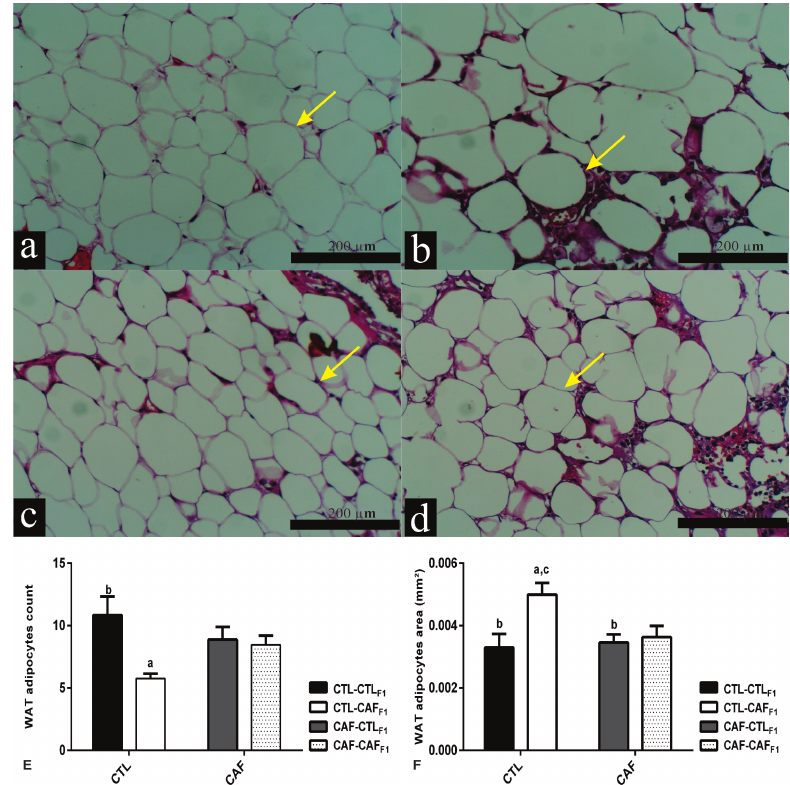
Figure 1 - Effects of exposure to CAF diet during pre and post weaning, alone or in combination, on histological aspects of the WAT depot of male adult F1 offspring at 100d of age. Representative histology of the WAT depot with H&E staining (100X magnification); a-d ; Scale bars: 200 μm. In all section were circled all adipocyte (field to field) and the area (mm2) was measured and the number of adipocytes also was counted for all cells (Figure f and e, respectively). Qualitative data are expressed as mean ± standard error mean (SEM) showing comparison between the different groups. Adipocyte is indicated by yellow arrows. a comparison with group CTL-CTL F1 , control offspring born from dams that were fed on control diet; b CTL-CAF F1 , cafeteria offspring born from dams that were fed on control diet; c CAF-CTL F1 , control offspring born from dams that were fed on a cafeteria diet; d CAF-CAF F1 , cafeteria offspring born from dams that were fed on a cafeteria diet; p-values (p<0.05) by ANOVA followed by Post Hoc Tuckey´s test. The number of animals analyzed was 5-7 rats per group from five different